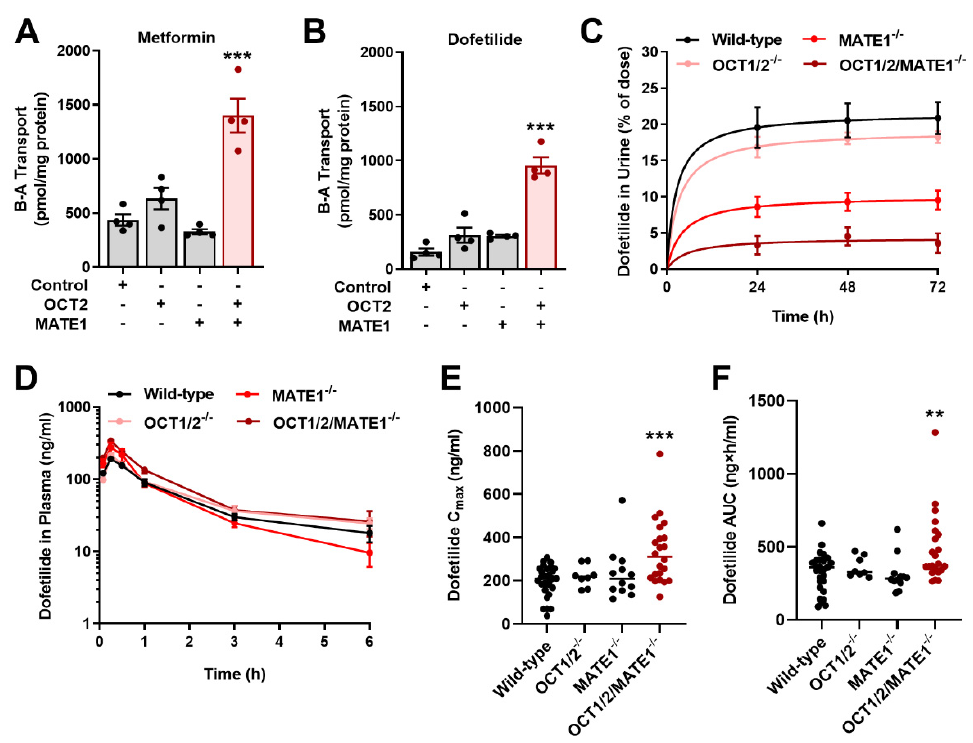
Figure 3. Inhibition of MATE1 reduces renal elimination of dofetilide. Characterization of the basolateral to apical (B-A) transport of [ 14 C] metformin ( A ) [ 3 H] dofetilide ( B ) in single transfected MDCK-VC, MDCK-OCT2, MDCK-MATE1, and double-transfected MDCK-OCT2-MATE1 cell lines. Transcellular transport was quantified by measuring the amount of metformin or dofetilide added basolaterally to the monolayers and appearing in the apical compartment after a 60-min incubation. Statistical analysis was performed using an unpaired two-sided Student’s t -test with Welch’s correction: *** p < 0.001 vs. MDCK-VC. ( C ) Urinary excretion of dofetilide in female wild-type, OCT1/2-deficient, MATE1-deficient, and OCT1/2/MATE1-deficient mice (n = 5) following a single i.v. dose of dofetilide (2.5 mg/kg). ( D ) Plasma concentration-time profile of dofetilide in female wild-type, OCT1/2-deficient, MATE1-deficient, and OCT1/2/MATE1-deficient mice (n = 5) receiving a single oral dose of dofetilide (5 mg/kg). ( E ) Peak concentration (C max ) of dofetilide and ( F ) area under the curve (AUC) of dofetilide after a single oral dose in female mice of varying transporter genotypes. Statistical analysis was performed using one-way ANOVA with Dunnett’s post hoc test: ** p < 0.01, *** p < 0.001, compared with wild-type mice. All data represent the mean ± SEM.